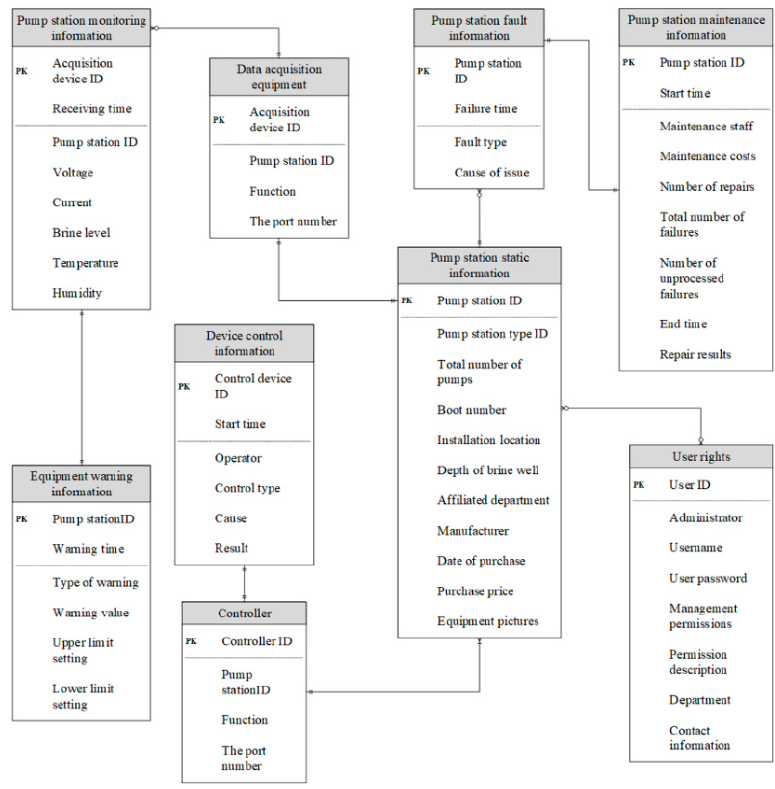
Figure 4. Entity relationship diagram for database.